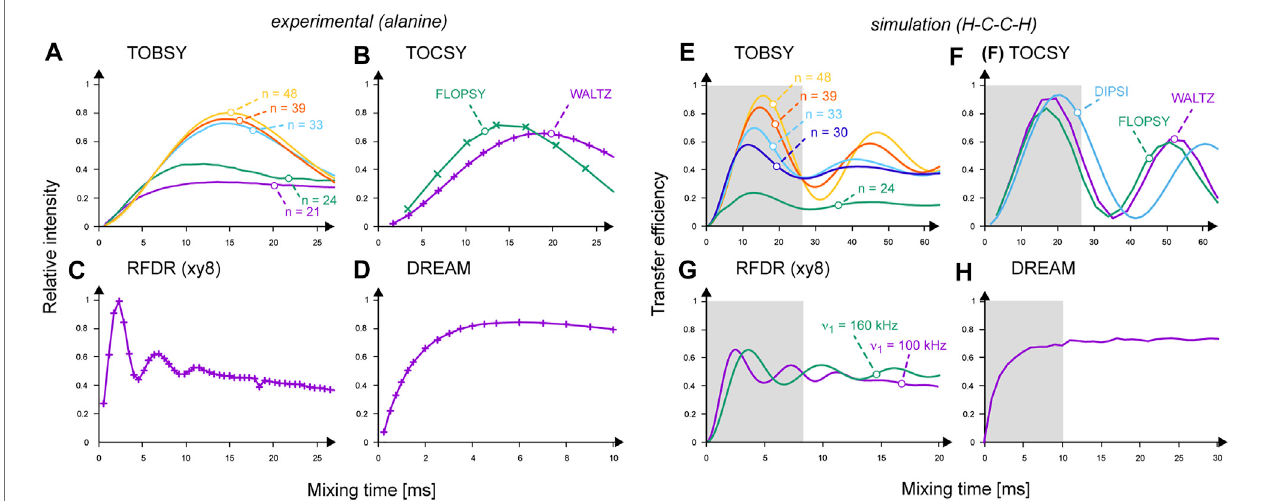
FIGURE 4 | (A – D) Performance of 13 C mixing schemes observed experimentally in 13 C – 13 C 2D spectra on 2,3- 13 C 2 -labeled alanine: (A) TOBSY C9 1 n with n = 21, 24, 33, 39, and 48 are labeled and color-coded as purple , green , cyan , red , and orange curves, respectively; (B) FLOPSY-16 (in green ) and WALTZ-16 (in purple ); (C) RFDR at ν 1 = 100 kHz; (D) DREAM. Cross-peak intensities were normalized to the most intense point in the RFDR series. Experimental points are connected with lines for eye guidance only. (E – H) Buildup of transferred 13 C magnetization (absolute transfer ef fi ciency) in a two 13 C- and two 1 H-spin system simulated in SIMPSON. (E) TOBSY C9 1 n with n = 24, 30, 33, 39, and 48 are labeled and color-coded as green , dark blue , cyan , red , and orange curves, respectively; (F) FLOPSY-16 (in green ), DIPSI-3 (in light blue ) and WALTZ-16 (in purple ); (G) RFDR at ν 1 = 100 (in purple ) and 160 kHz (in green ); (H) DREAM. Gray boxes indicate the mixing time ranges sampled experimentally on